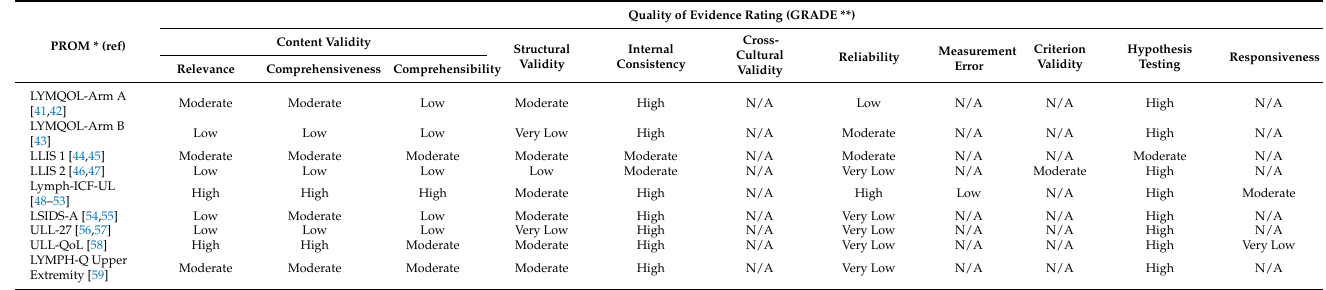
Table 6. Quality of evidence for measurement properties of